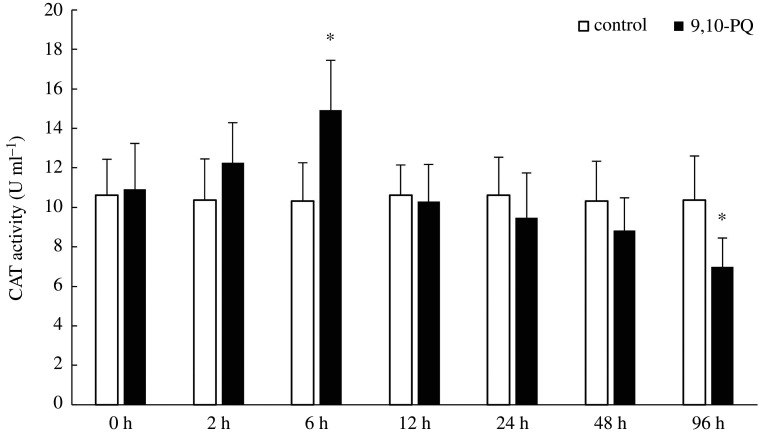
CAT activity in plasma of T. obscurus under sublethal exposure to 9,10-PQ. The data indicate mean (nine fish samples from three aquaria) and s.d. Significant differences (p < 0.05) between control and 9,10-PQ treatment are marked by asterisks (Student's t-test).